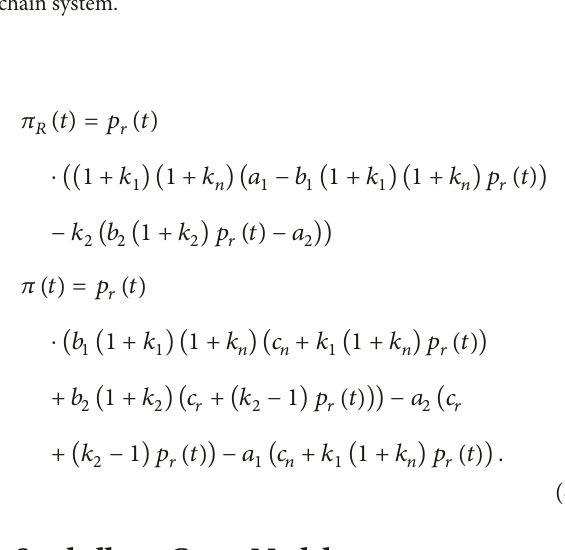
Figure 1: The supply chain